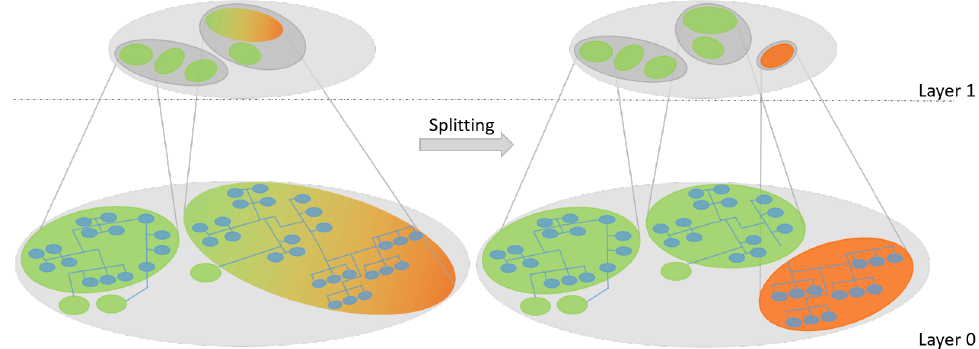
Figure 1. A conceptual representation of a splitting operation in a two-layer